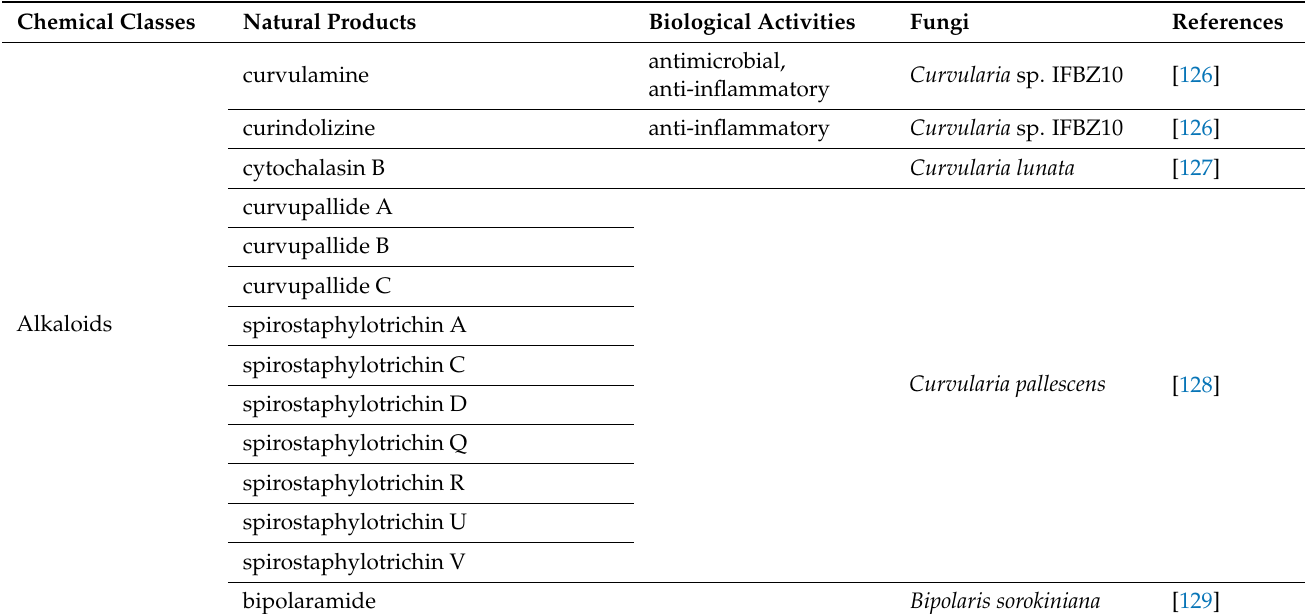
Table 4. Some secondary metabolites isolated from Curvularia and Bipolaris and their classes and biological